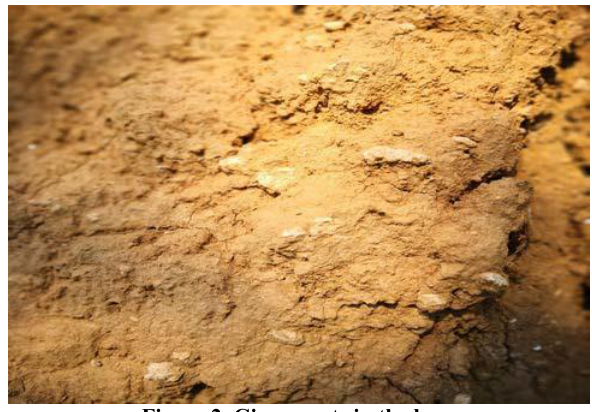
Figure 2. Ginger nuts in the loess